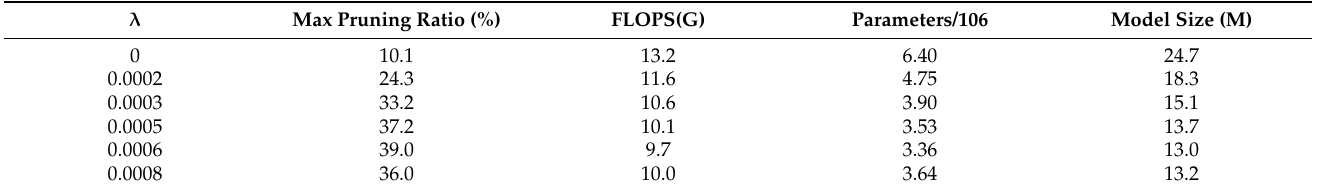
Table 5. The maximum pruning ratio and network parameters when λ changes from 0 to